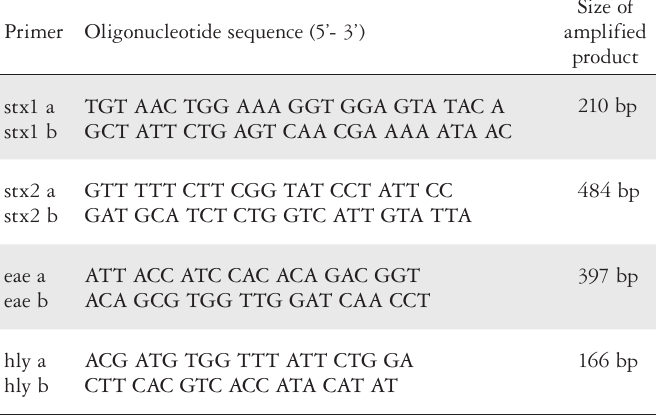
Table 1. Primers used in PCR to amplify specific fragments from E. coli stx1, stx2 , eae and hly EHEC genes Primer Oligonucleotide sequence (5’- 3’)